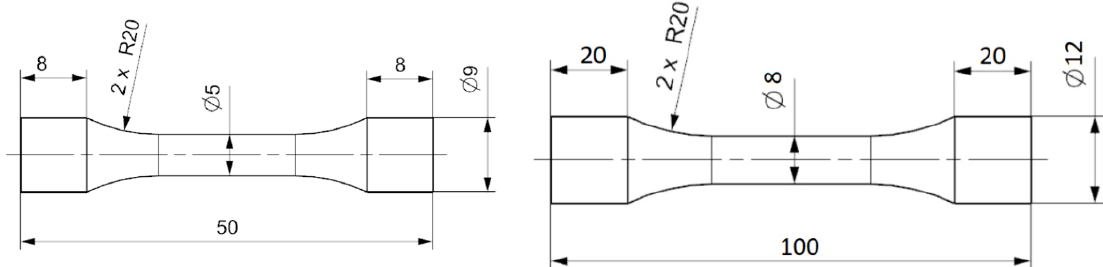
Figure 2. Shape of samples produced additively ( left ) and conventionally ( right ). The measurement of the strain was carried out by employing a non-contact method using DIC (digital image correlation) technology (Dantec Q450) and confronted with the measurement using an extensometer. The DIC measurement allowed the comparison of the basic material properties: Young’s modulus and Poisson’s ratio. The difference in Poisson ratio (cast 0.35, AM 0.36) was not significant. The Young’s modulus of cast 82 GPa compared to 73 AM already shows a significant difference, which is caused by the absence of eutectically free silicon. The tensile test results of both analysed materials are shown in Figure 3.